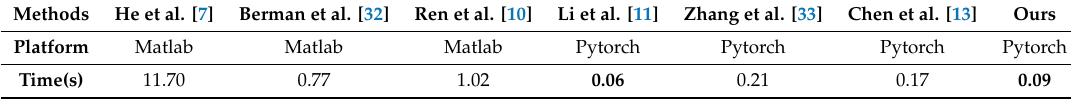
Table 4. Comparison of average running time on railway test images (in seconds).